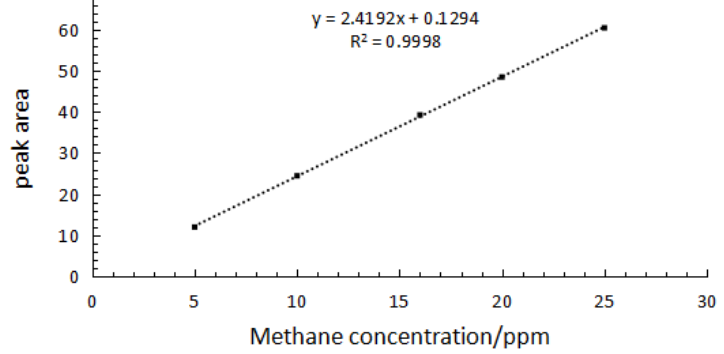
Figure 6. The working curve of methane content determination.